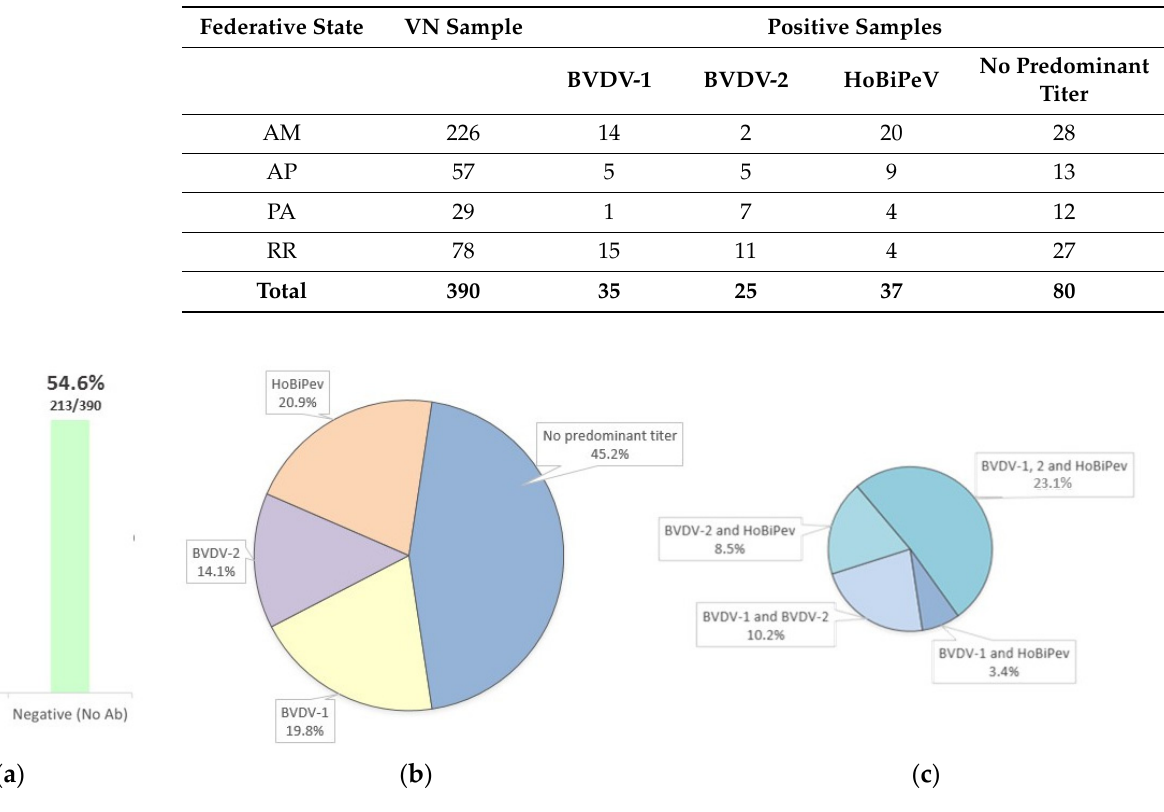
Figure 3. Neutralizing antibody titers were determined in bovine serum samples tested by VN assay against BVDV-1, BVDV-2, and HoBiPeV strains: ( a ) Percentage of samples with neutralizing antibodies against bovine pestiviruses; ( b ) During cross-neutralization, samples with titers higher than 4-fold for one specific species are considered to be raised by the infection of that species; ( c ) For cross-neutralization results with titers against more than one species (but <4-fold) the samples had no predominant titer against one specific pestivirus species. Table 2. Number of samples for which the species that raised the antibodies could be determined (BVDV-1, 2 and HoBiPeV) or not, by federative state.